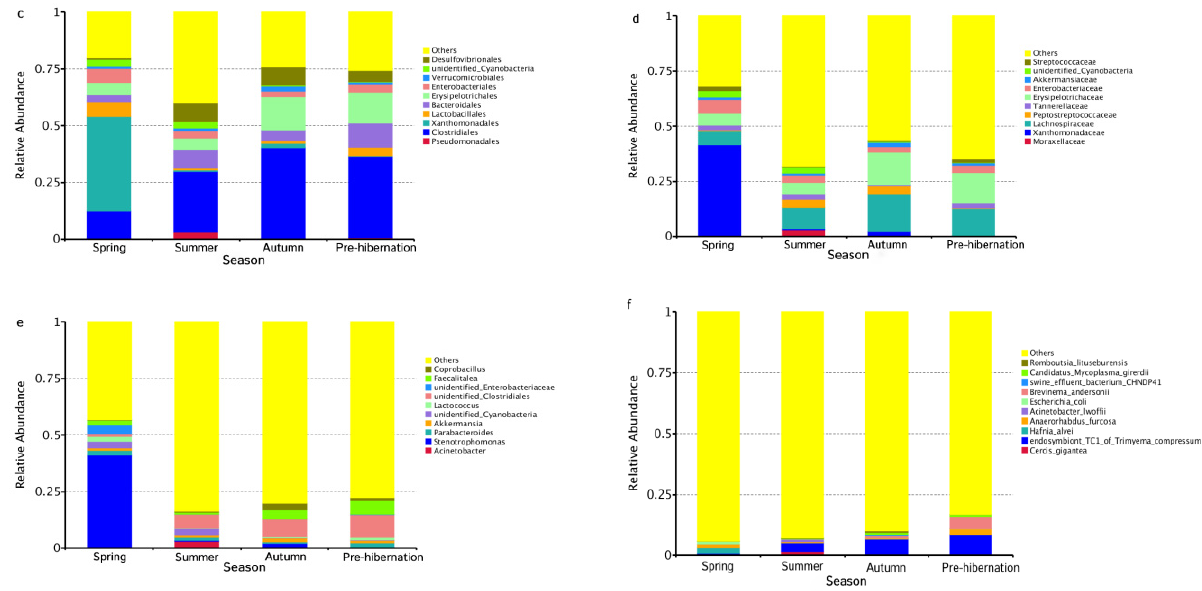
Figure 1. The relative abundance of bacterial compositions in different seasonal groups at different levels, phylum ( a ), class ( b ), order ( c ), family ( d ), genus ( e ), and species ( f